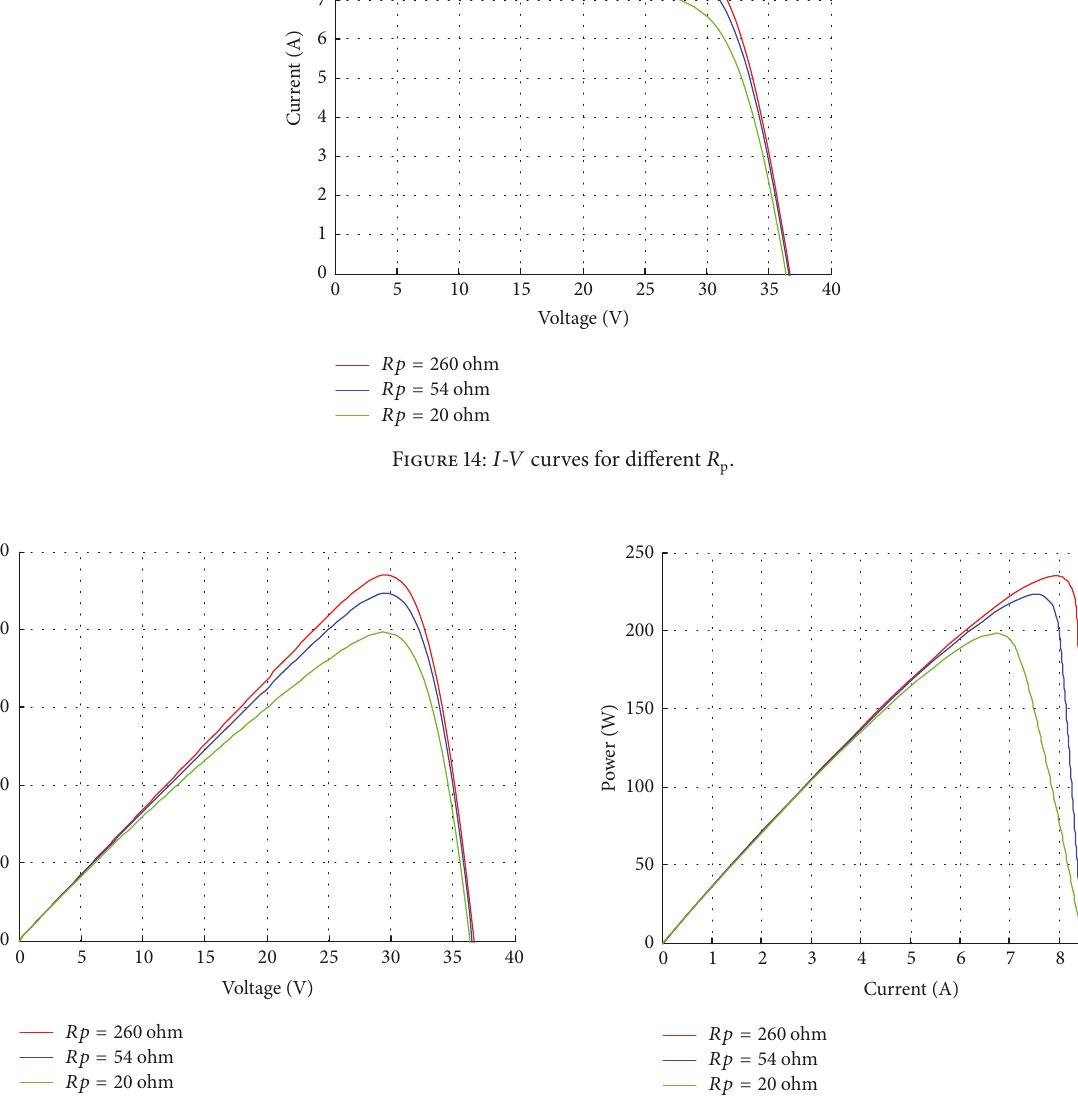
Figure 15: 𝑃 - 𝑉 curves for different 𝑅 p . Figure 16: 𝑃 - 𝐼 curves for different 𝑅 p